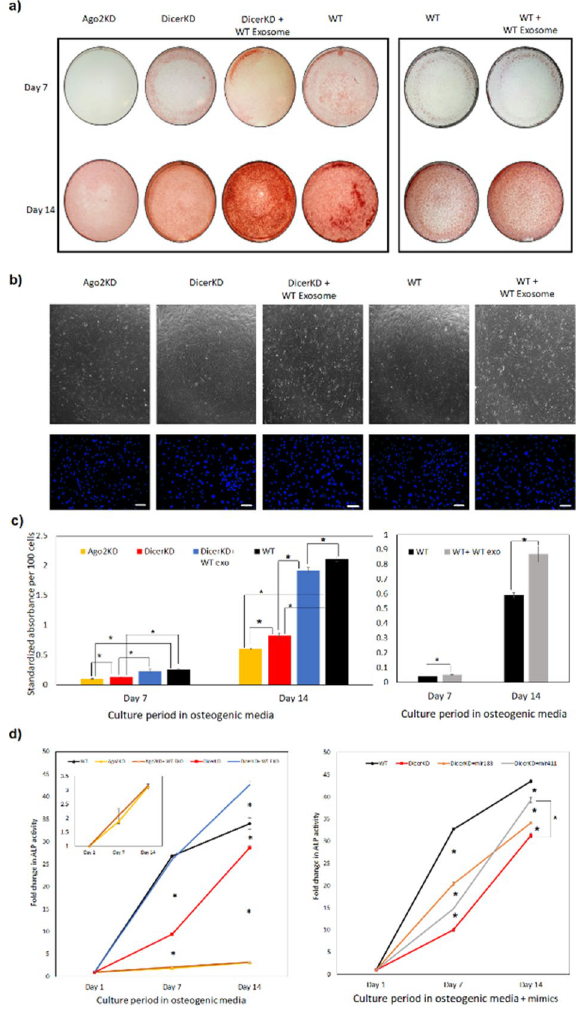
Figure 3. Differentiation experiments. ( a ) Alizarin Red staining demonstrate impaired calcium deposition in AGO2KD cells after 7 and 14 days of culture in osteogenic medium. DicerKD cells produced less calcium deposits compared to WT hMSCs at day 7 and 14. Complementation of DicerKD and WT hMSCs with WT exosomes considerably improved calcium deposition. ( b ) Brightfield microscopic images of experimental groups at day 7 captured at 4 × magnification demonstrated similar confluency level. DAPI staining showed similar number of nuclei per field among different groups. White scale bars are equal to 100 µm. ( c ) Quantitation of Alizarin Red staining revealed a statistically significant (* P < 0.01) difference among experimental groups. ( d ) ALP activity was measured using 45 µg of protein from each sample and calculated as standardized fold change at day 7 and 14 compared to day 1 in each group. ALP activity was significantly lower (* P < 0.01) in AGO2KD and DicerKD groups compared to WT hMSCs at day 7 and 14 in osteogenic medium. Complementation of DicerKD hMSCs with WT exosomes restored ALP activity at day 7, and increased ALP activity significantly (* P < 0.01) at day 14 compared to WT hMSCs. Complementation of AGO2KD hMSCs with WT exosomes did not significantly change ALP activity at days 7 and 14 (insert: magnified plot of ALP activity at day 7 and 14 for AGO2KD hMSCs). The addition of miR-183-5p and miR-411-5p mimics to DicerKD cells significantly (* P < 0.01) increased ALP activity at day 7 and 14. Fold changes in ALP activity was calculated compared to day 1 within each group. One-way ANOVA and Tukey’s post-hoc test was used for all statistical